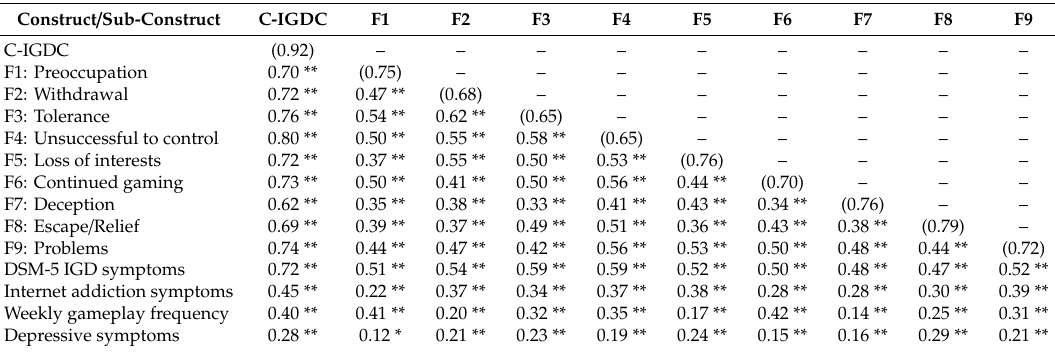
Table 2. Reliability and bivariate correlations of the C-IGDC and its nine sub-constructs ( N = 464). Construct /